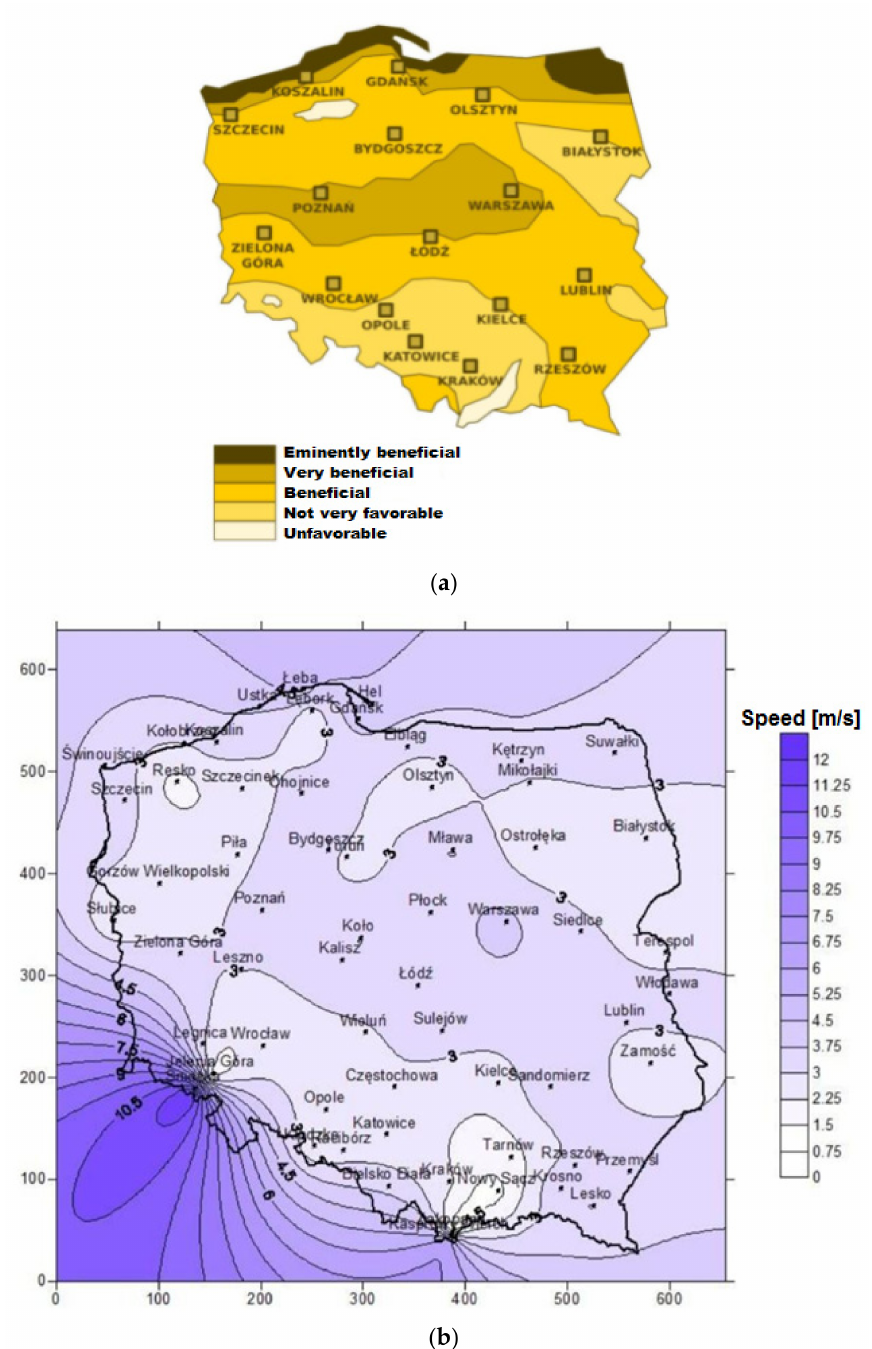
Figure 1. ( a ) Wind conditions in Poland. Source: https://www.instalacjebudowlane.pl/7935-24-87 -elektrownie-wiatrowe--wietrznosc-w-polsce.html (accessed on 8 October 2021). ( b ) Wind speeds in Poland. Source: https://remont.biz.pl/energia-odnawialna/zasoby-energii-wiatru-na-terenie- polski-mapa-lokalizacji-w-ktorych-wykorzystamy-wiatrak-do-produkcji-energii-elektrycznej/ ?fbclid=IwAR2FDyApg_9f3H8blMmpTi_x_BSXgOk7deX5ItihZSu14Vk1_Kzw4PYKLCk (accessed on 8 October